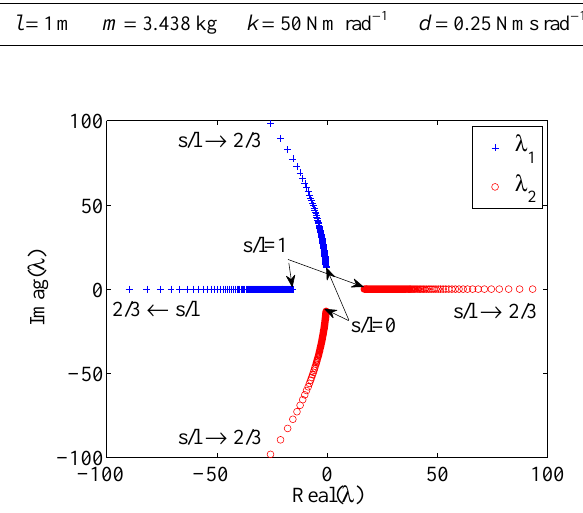
Figure 8. Eigenvalues of zero dynamics for rotational